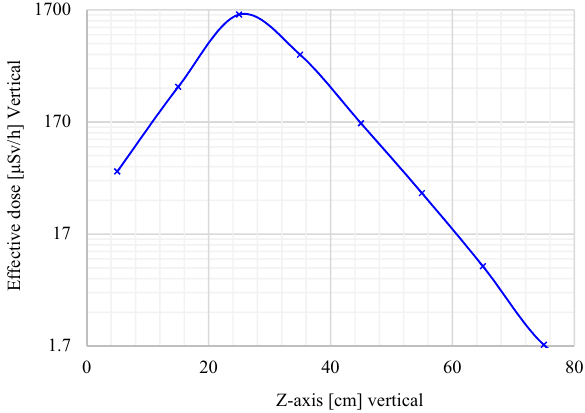
Figure 9. Effective dose profile inside the DSRSs container’s [from 0 to 74.00 cm] where the position of 241 Am/ Be source pre-encased in a P60 capsule encapsulated into the concrete-filled drum is set between 21.20 and 49.70 cm.